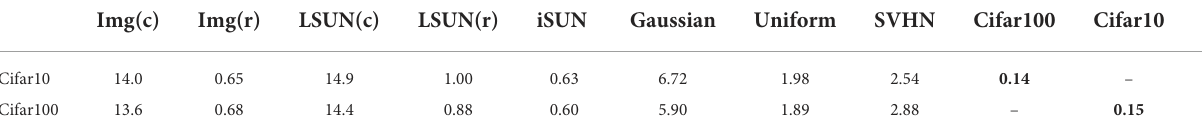
TABLE 5 The maximum mean distance between ID data and different OOD data, the smallest distance is shown using bold and “–” represents a possible case of semantic overlap and is therefore not computed. Img(c) iSUN